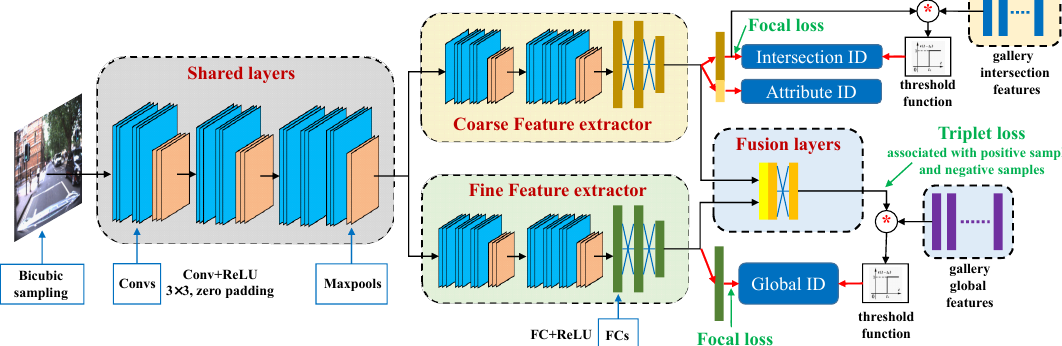
Figure 3. The proposed hybrid double-level network consists of two branches. The coarse features are concatenated into the mainstream to provide different level information for the generation of final feature. The similarity between the query feature and gallery features determines the global pose by threshold function. A coupled cluster losses help to train the network with three steps of forward